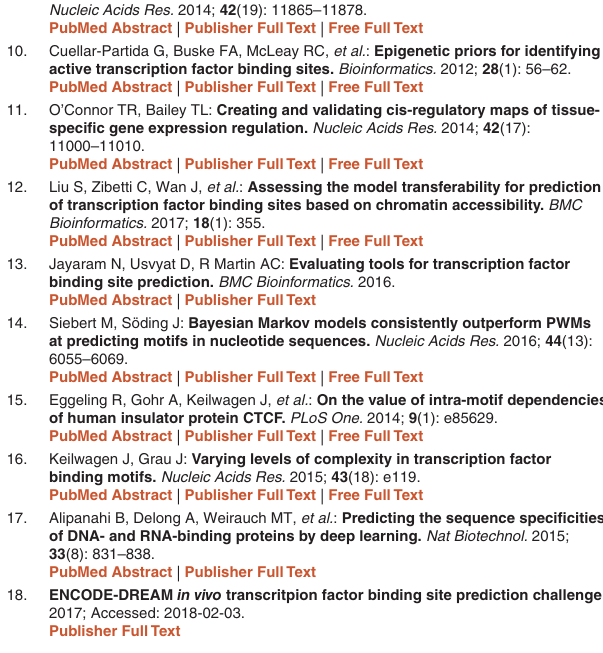
Supplementary Figure 3 (https://doi.org/10.6084/m9.figshare. 9364268.v1)